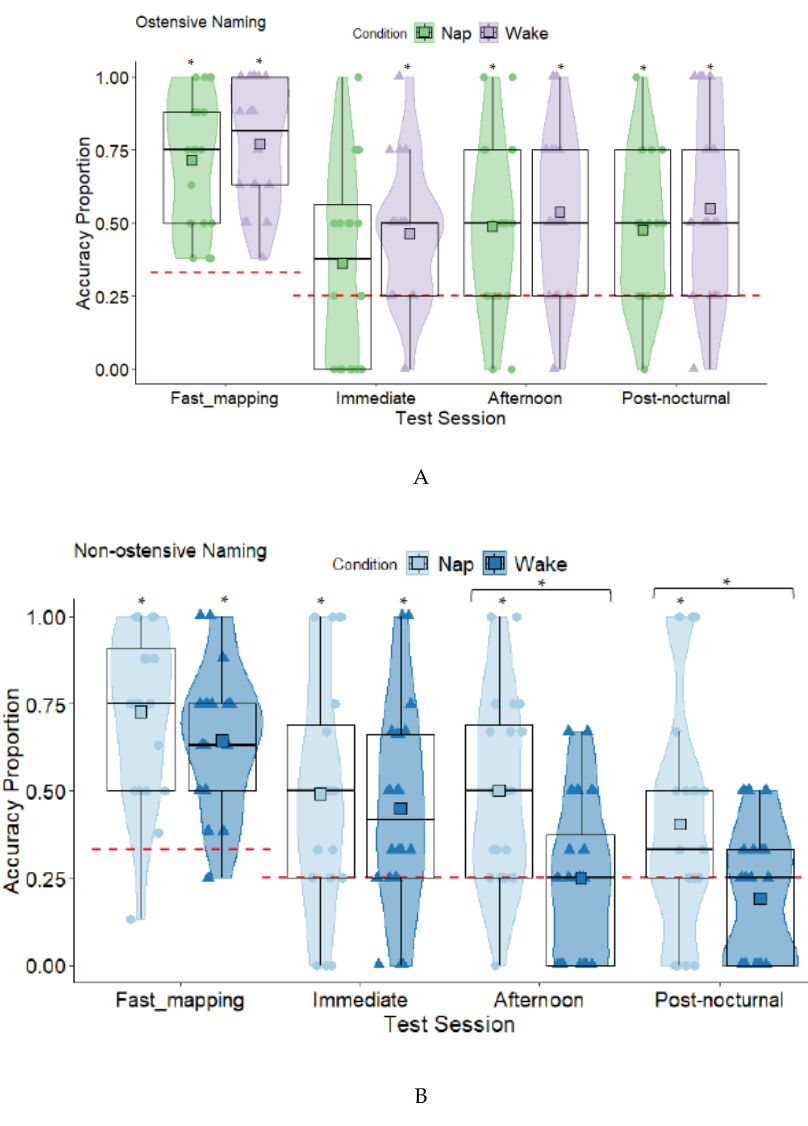
Figure 4. Box and Violin Plots for Accuracy During Fast Mapping, and Immediate, Afternoon, and Post-nocturnal Reten- tion Tests for the Ostensive (A) and Non-ostensive Naming Groups (B from Axelsson et al. [46] presented here for com- parison)(Squares Denote Means; Red Dashed Lines Denote Chance Level, * = p < 0.05).